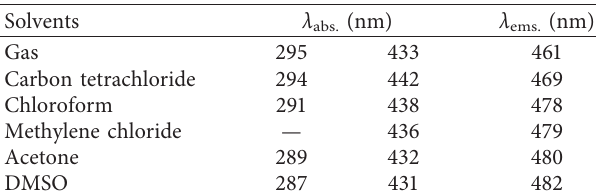
Table 5: Calculated maximum absorption ( λ abs ) and